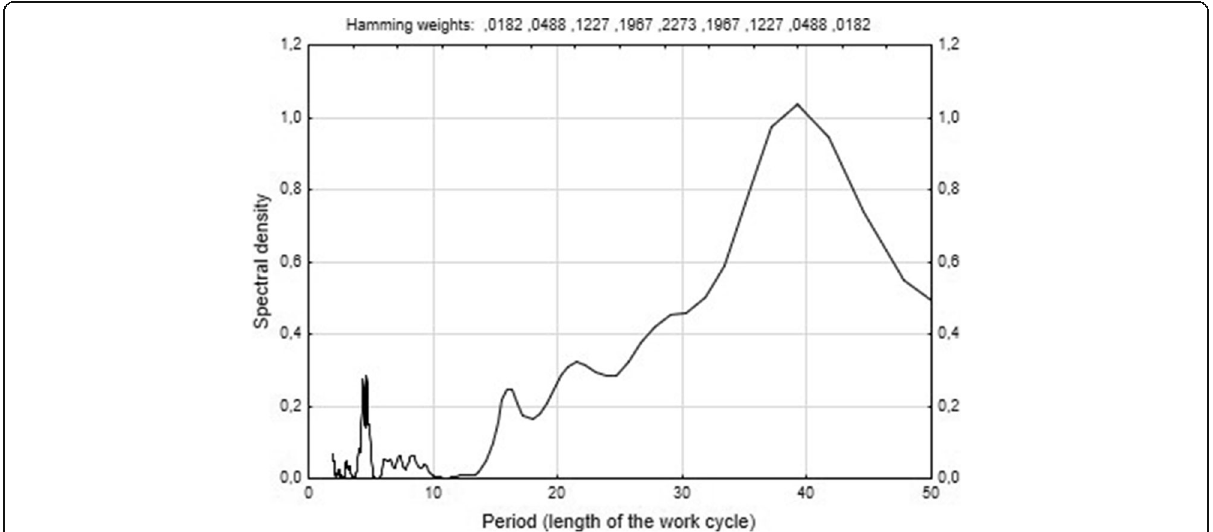
Fig. 5 Fragment of a periodogram of a harvester operating in mature stands